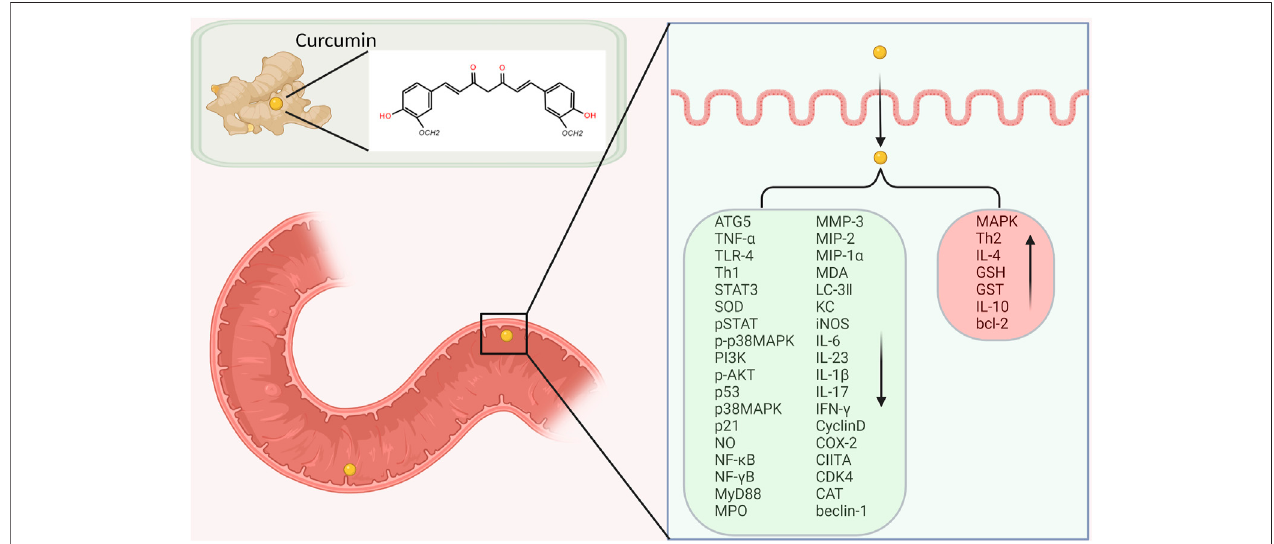
FIGURE 3 | Curcumin ’ s molecular targets in in fl ammatory bowel disease (IBD) treatment.